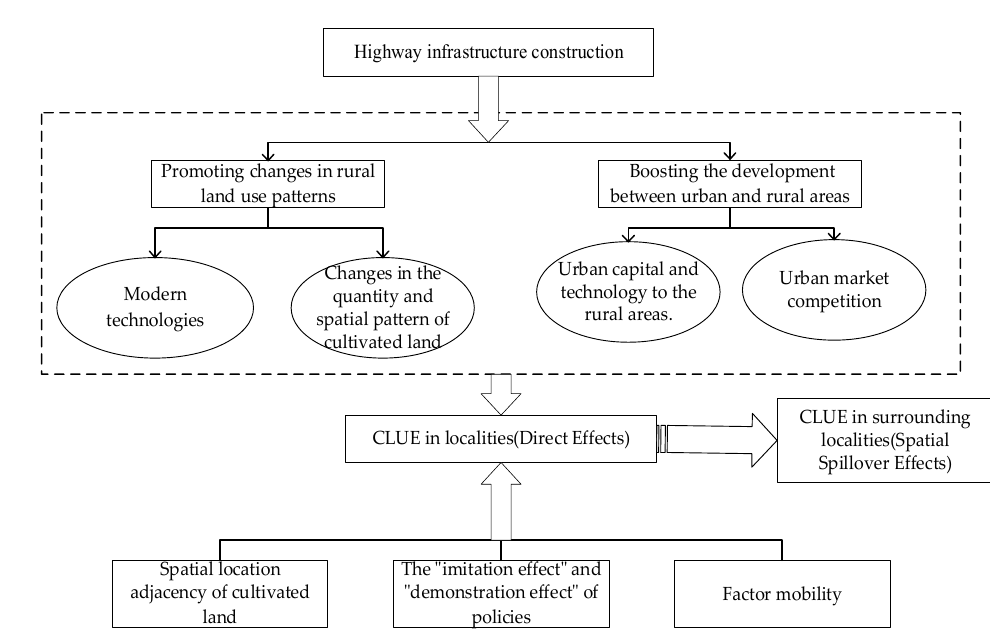
Figure 1. Spatial spillover effects of highway infrastructure construction on CLUE.